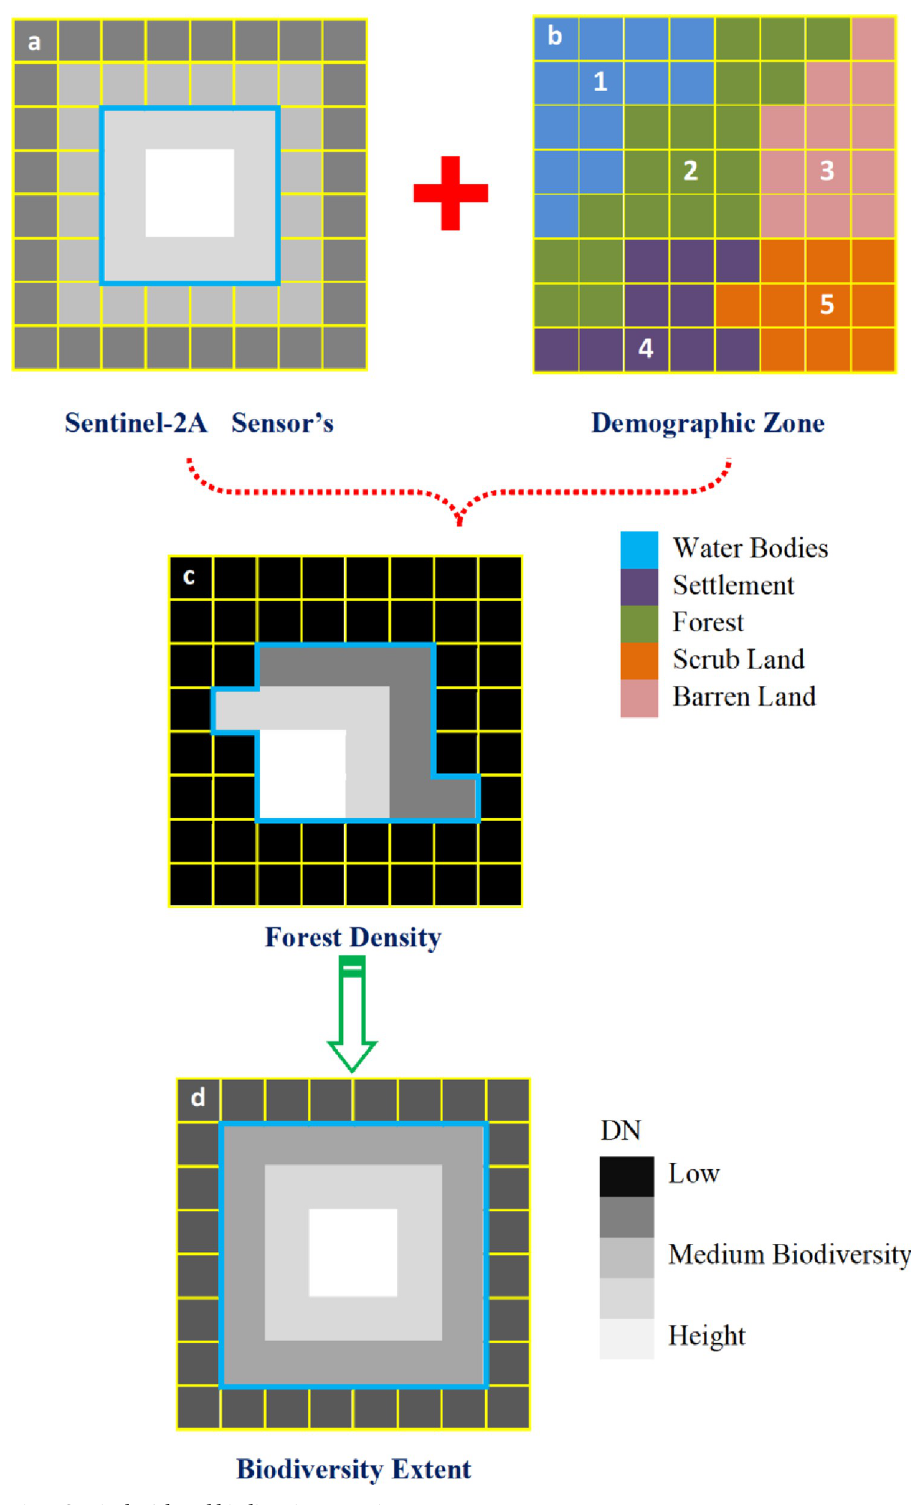
Fig 2. Sentinel-2A based biodiversity